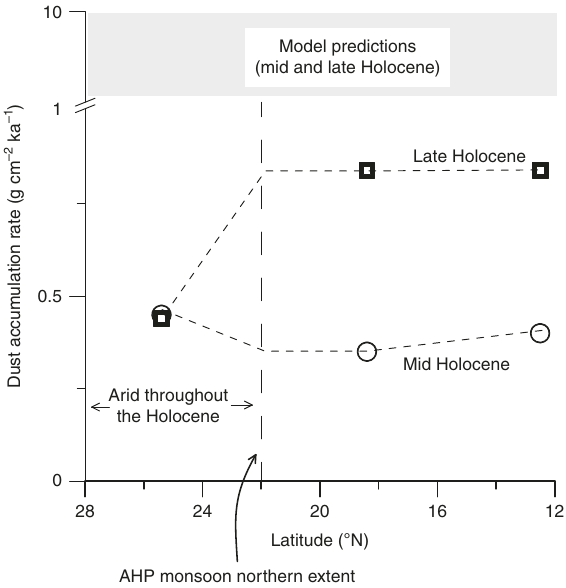
Fig. 4 Dust accumulation rates in the eastern Sahara during the mid and late Holocene (6 – 7 and 2 – 4 ka, respectively) from models and 230 Th xs - normalized rates (this study). Model predictions 45,46 overestimate the observed values by an order of magnitude (note the break in the axis) and therefore do not capture the African Humid Period (AHP) shift in dust fl uxes. Dust accumulation rates in the northern Red Sea along with environmental evidence suggest that the northeastern Sahara Desert was arid north of latitude ~ 22°N throughout the length of the